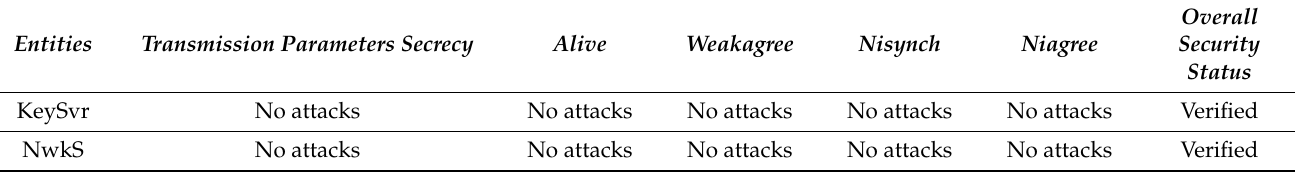
Table 4. KeySvr and NwkS security claims.